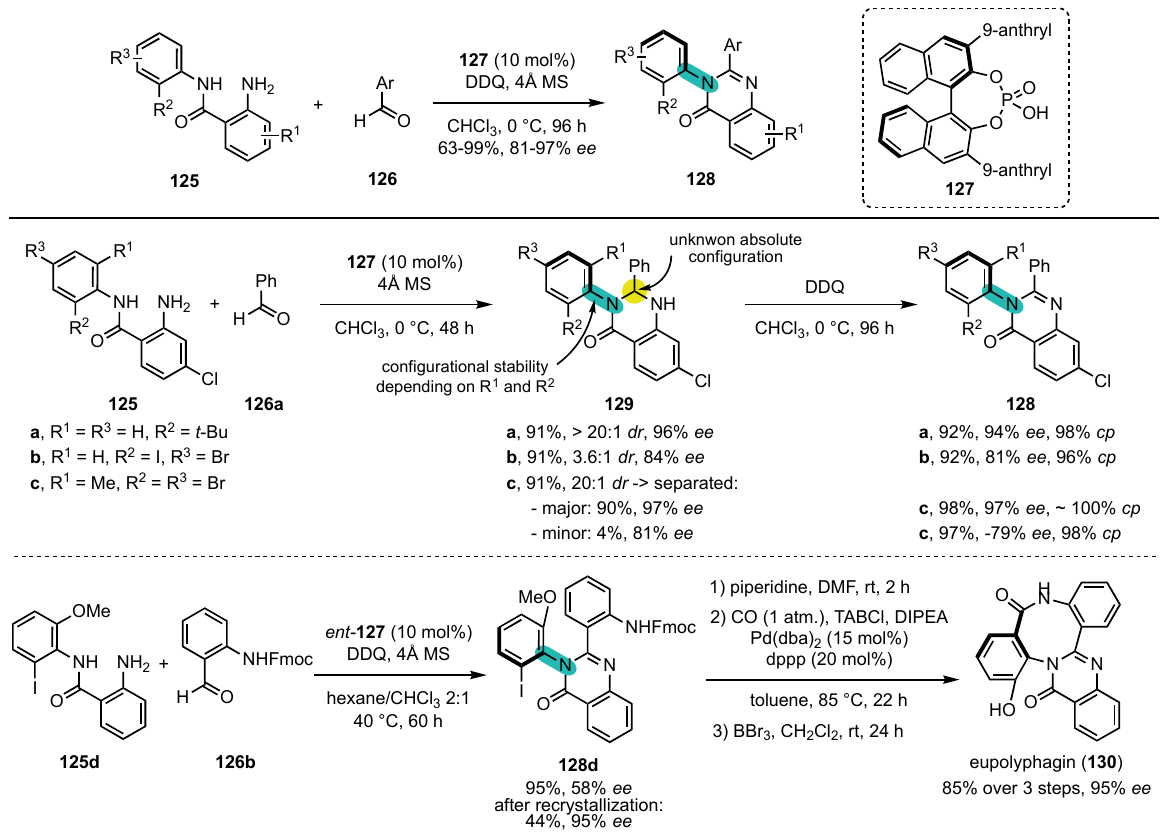
Scheme 29. Atroposelective synthesis of quinazolinones with a C-N stereogenic